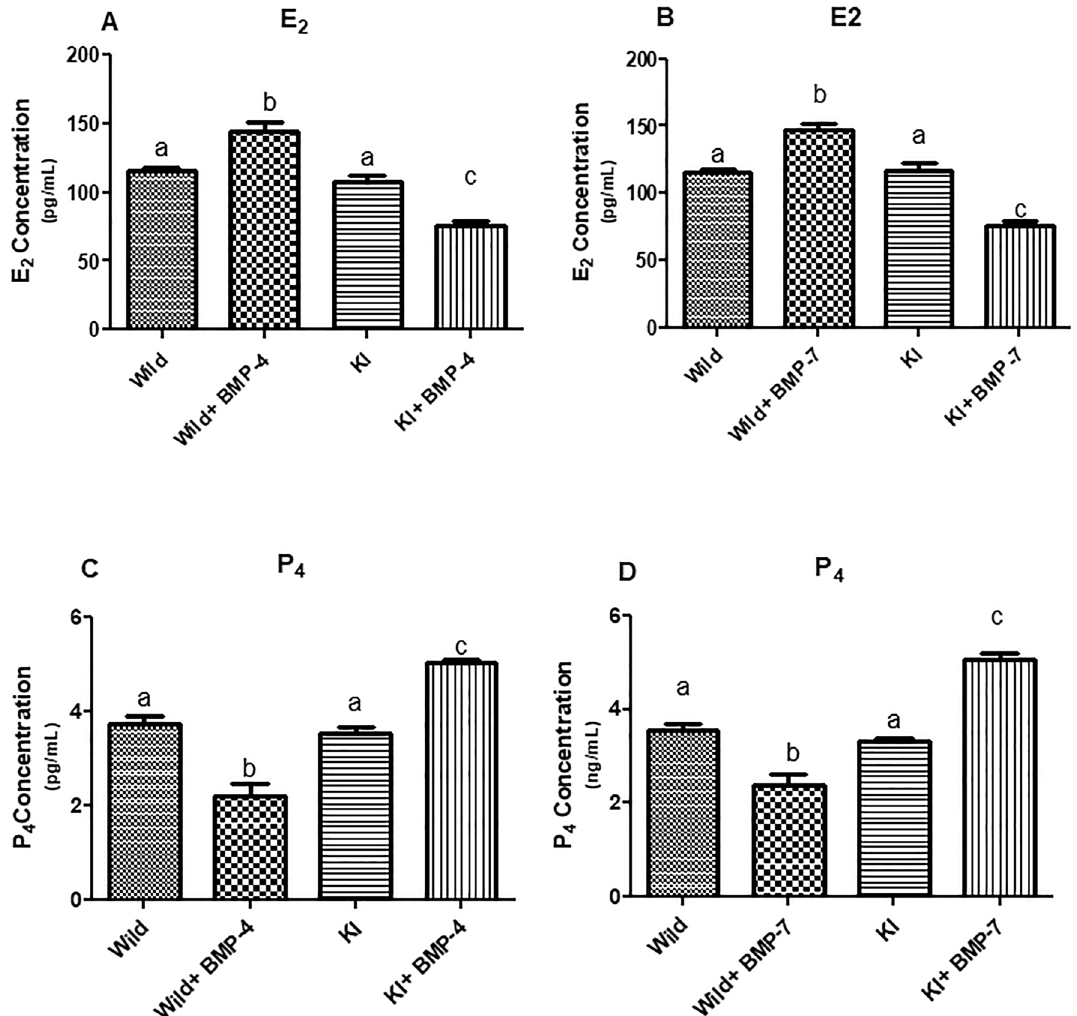
Figure 10. Effect of BMPR-IB gene KI on P4 and E2 synthesis in in vitro cultured granulosa cells stimulated with BMP-4 (50 ng/ml) or BMP-7 (100 ng/ml) for 72 h. All values are shown as mean ± SEM. Different superscripts denote statistically different values ( p < 0.05). Abbreviations: WT indicate wild type cells, WT + BMP-4/BMP-7 indicate wild cells treated with BMP-4 (50 ng/mL), KI indicate BMPR-IB gene knock out cells. KI + BMP-4/BMP-7 indicate KI cells treated with BMP-4(50 ng/ml) or BMP-7 (100